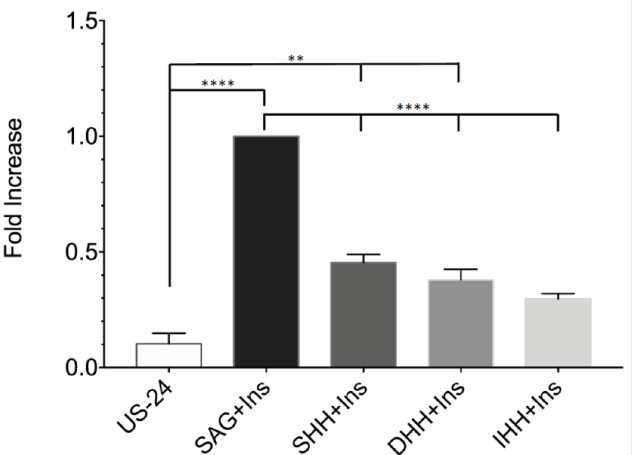
Figure 2. The activity of the recombinant natural Hh ligands was reduced compared to that achieved with the synthetic agonist SAG. Data represent the mean of CD24 expression measured by flow cytometry. The percentage of CD24 positive cells obtained with the US-24 medium with SAG and Insulin (SAG + Ins) was set as 1. The results obtained with the other three conditions are related to the CD24 induction achieved with SAG + Ins. The agonists’ concentrations were: SAG, 200 nM; Recombinant natural Hh ligands ( E. Coli ), 50 ng/mL. ( n = 3, error bars represent S.E.M., p value; **: p value < 0.01; ****: p value < 0.0001, complete statistical significance reported in Supplementary Materials Table